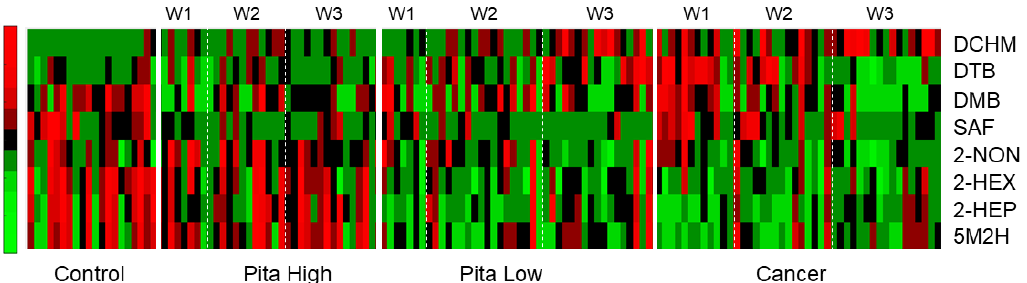
Figure 2. Hierarchical heatmap for the eight VOCs differentially expressed when comparing PH to cancer using approach 1. These VOCs show significant differences between cancer weeks 1–3 and control samples. PH shows a high degree of similarity with the control, and PL samples mirror VOC expression in the cancer sample class.